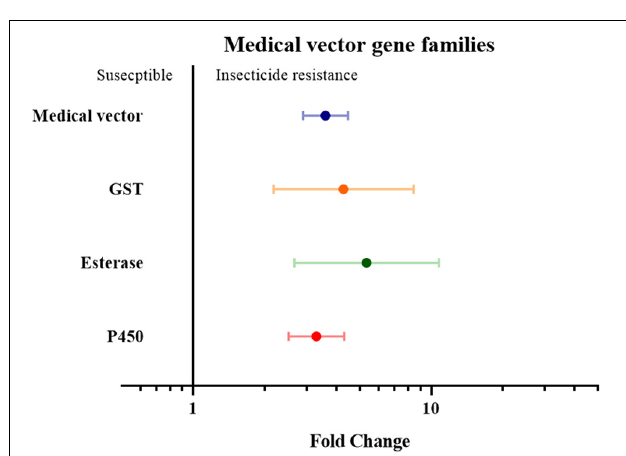
FIGURE 6 | Meta-analytical, sub-group estimate of the gene expression related to insecticide resistance, with 95% CI in the medical vector with different gene families and the P450 gene clade. The overall effect represents the collective effect of all the studies investigating the medical vector.